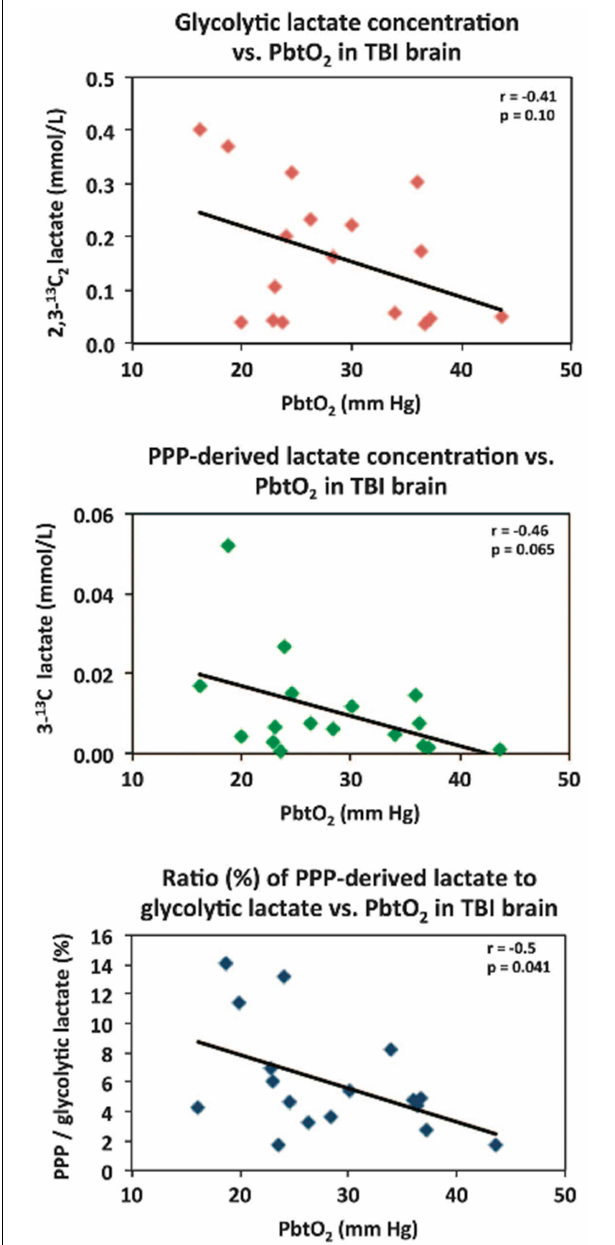
FIGURE 8 | Relationships in TBI brain for glycolytic lactate and pentose phosphate pathway (PPP)-derived lactate vs. PbtO 2 . Concentrations of glycolytic 2,3- 13 C 2 lactate (upper panel) and PPP-derived 3- 13 C lactate (middle panel) plotted vs. PbtO 2 . Lower panel: ratio (%) of PPP-derived 3- 13 C lactate to glycolytic 2,3- 13 C 2 lactate, plotted vs. PbtO 2 . Each data point represents the results of NMR analysis of the combined contents of 24 × 1 h of microdialysate collection vials from one microdialysis catheter, plotted against the corresponding PbtO 2 concentration expressed in mmHg, measured using a Licox oxygen probe placed alongside the microdialysis catheter in the brain. Lines are fitted by linear regression (statistics shown are Pearson’s correlation coefficient r and analysis of variance P –value). Data are from 13 TBI patients. Four of these thirteen had a second period of monitoring, making 17 data points in total for each correlation. Originally published by Jalloh et al. (2015) in J Cereb Blood Flow Metab 35: 111–120, and reproduced with permission of Nature Publishing